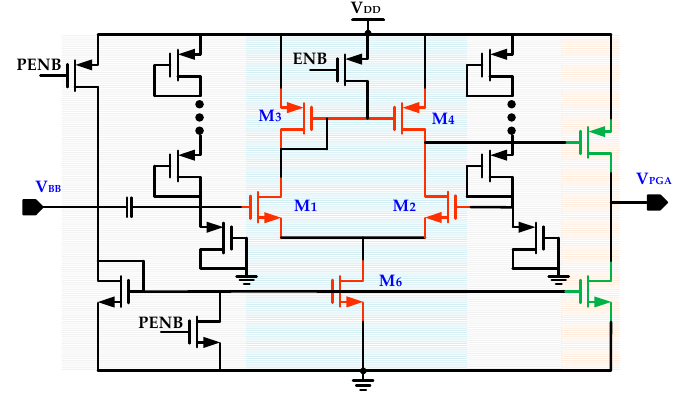
Figure 11. Programmable gain amplifier.